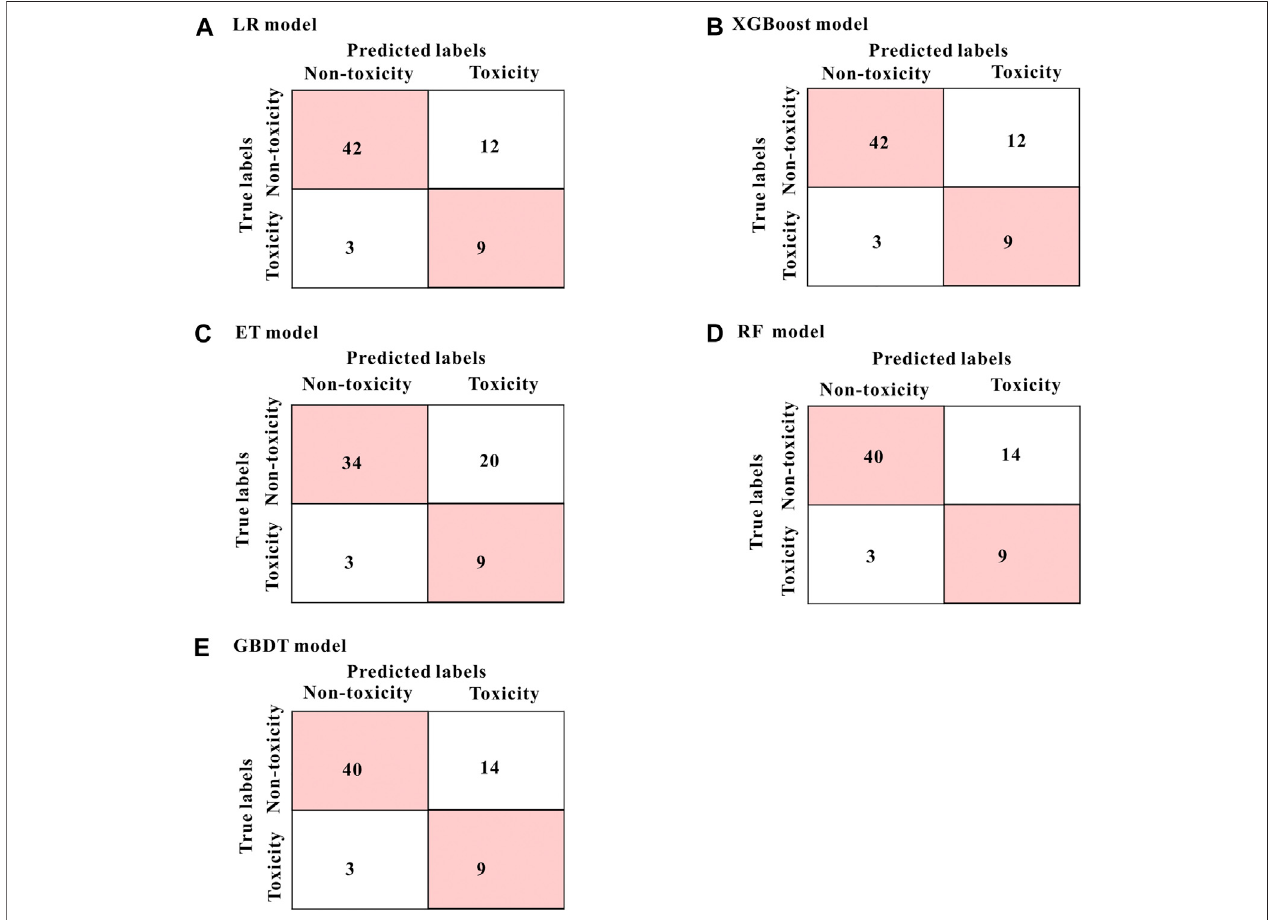
FIGURE 4 | The mixed matrix results of fi ve prediction models in the test set (A – E) . For example, in the XGBoost model (shown in B ), 42 of the 54 true non-toxic patients(pinkgrids intheupperleftcorner)wereaccurately predicted,while9ofthe12true toxicpatients (pink gridsinthelowerright corner)wereaccurately predicted. Other models (B – E) are in the same analogy. All results were at the threshold of 0.5.